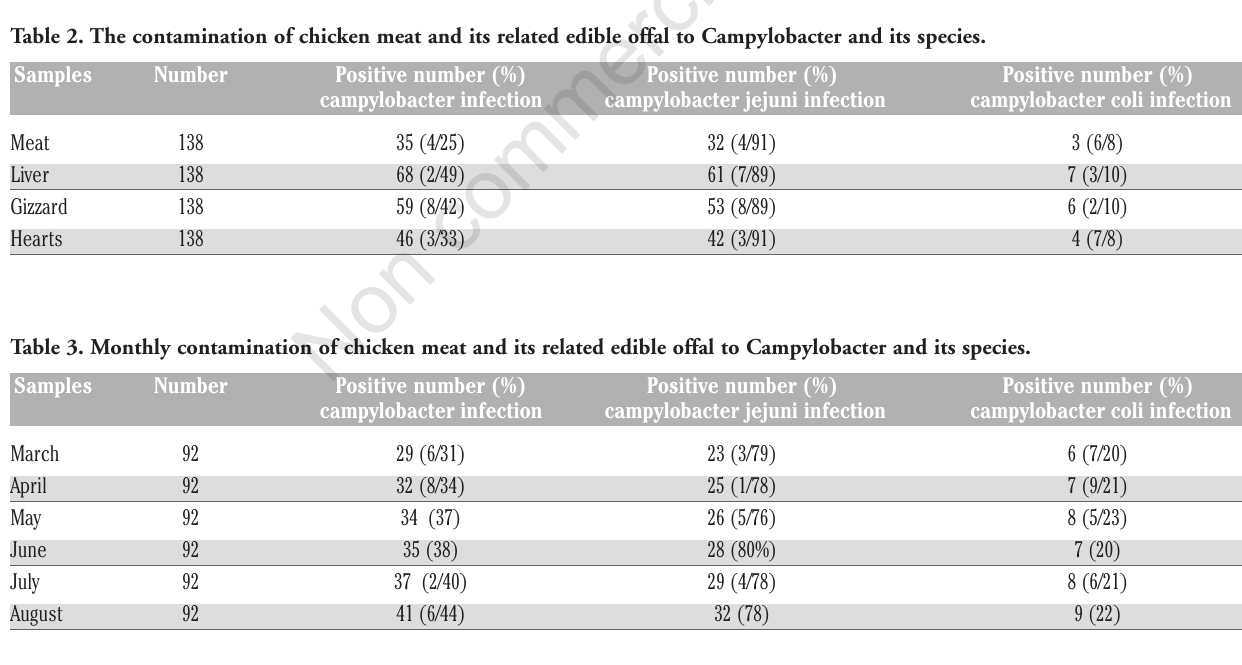
Table 4. Seasonal contamination of chicken meat and its related edible offal to Campylobacter and its species.